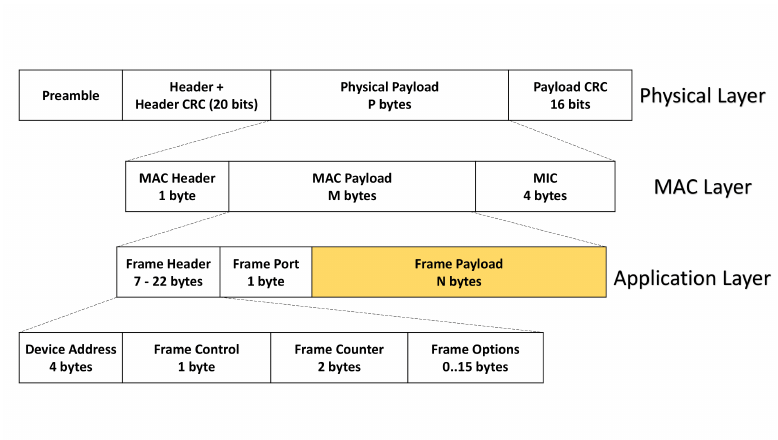
Figure 3. LoRa frame